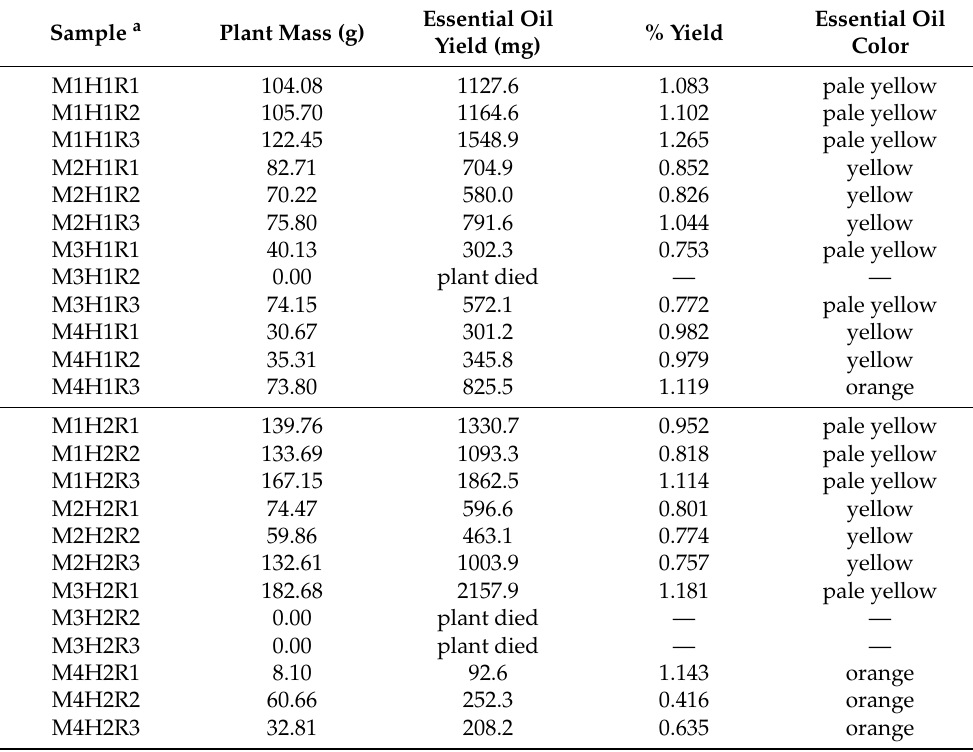
Table 3. Hydrodistillation details of Pycnanthemum virginianum cultivated in North Alabama. Sample